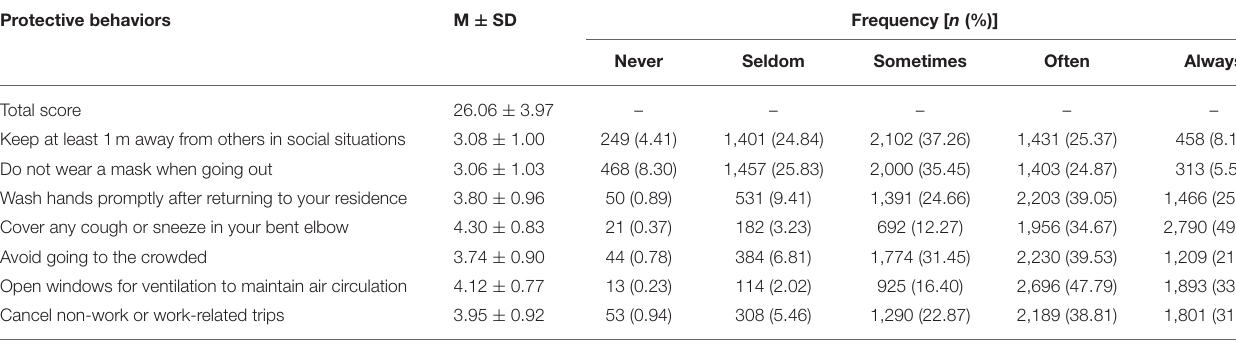
TABLE 2 | The status of protective behaviors for Chinese college students following vaccination ( N = 5,641). Protective behaviors